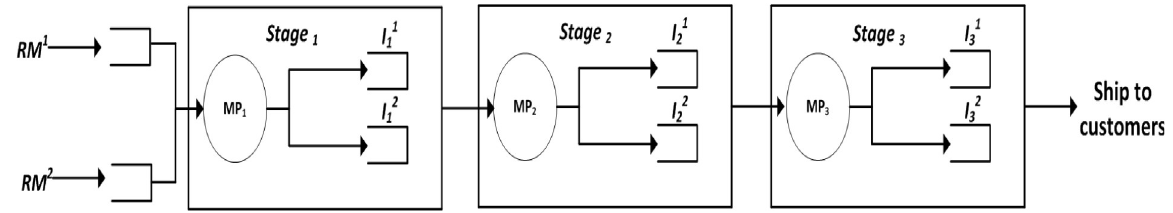
Figure 1. Case-1 two-product three-stage manufacturing system